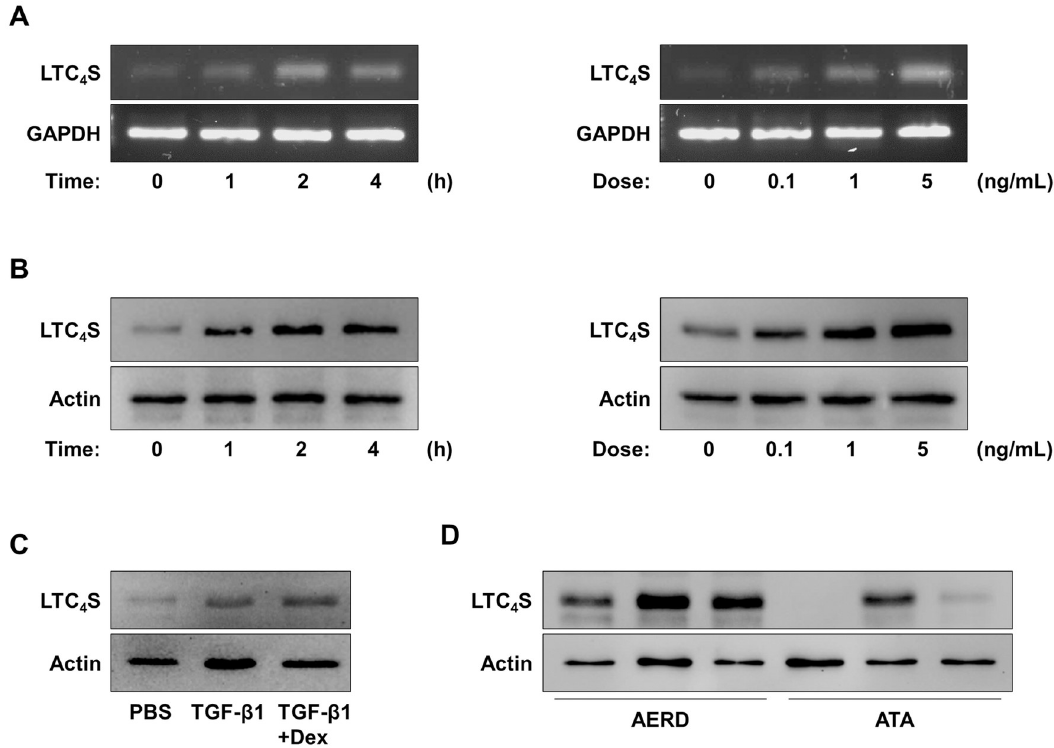
Fig 2. Effect of TGF- β 1 on LTC 4 S expression in human peripheral eosinophils. Effect of TGF- β 1 on (A) LTC 4 S expression and (B) LTC 4 S levels in peripheral eosinophils in a time- or dose-dependent manner (samples from 3 asthmatic patients were pooled). (C) Function of dexamethasone against TGF- β 1 treatment (samples from 3 asthmatic patients were pooled). (D) Comparison of LTC 4 S levels between ARED and ATA patients (n = 3 asthmatic patients per group).